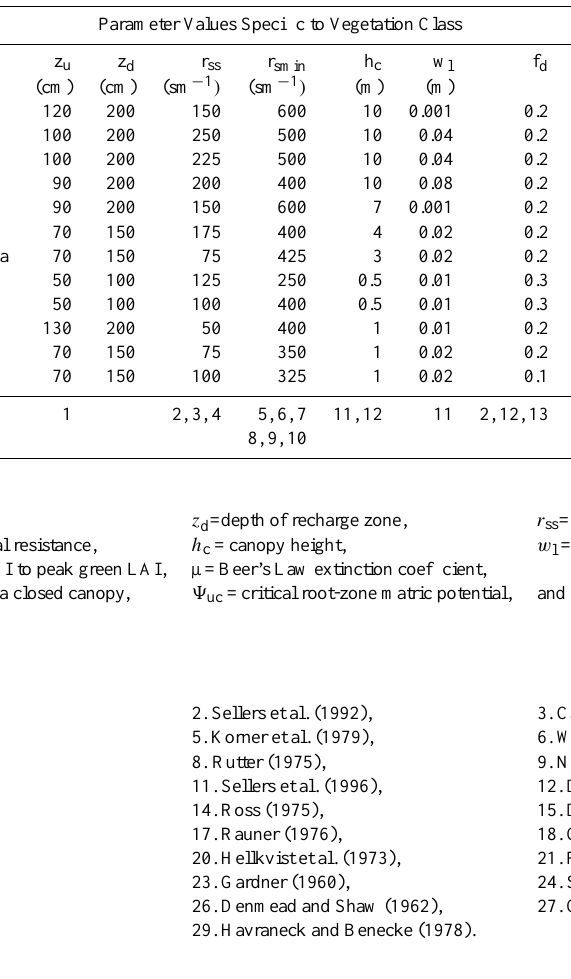
Table 1. Parameter values of vegetation classes.